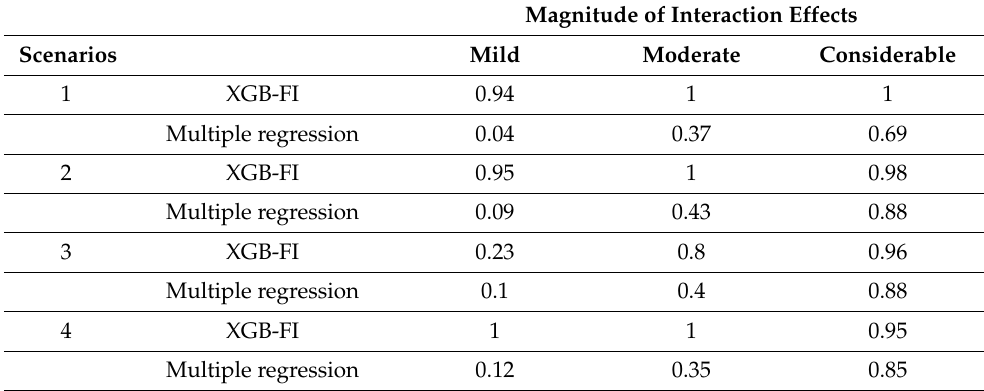
Table 4. Power comparison under Scenarios 1 to